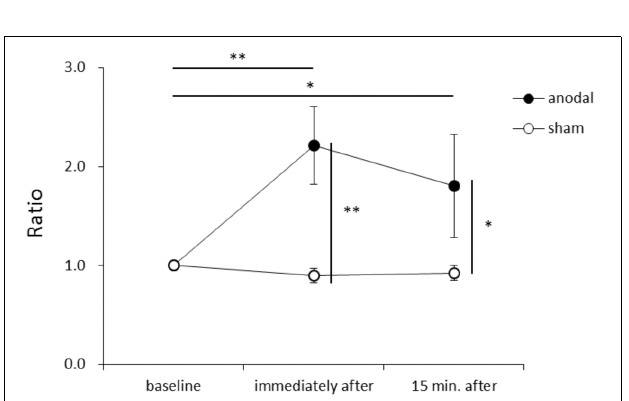
FIGURE 2 | Serial changes in (cid:49) EMG onset before, immediately after, and 15 min after anodal or sham transcranial direct current stimulation (tDCS) over the supplementary motor area (SMA). (cid:49) EMG onset was calculated by subtracting the time of EMG burst onset of the biceps femoris from that of the activation onset of the deltoid anterior muscle. Data were normalized to average value at baseline (mean ± standard error of the mean). ∗ p < 0.05, ∗∗ p < 0.01.